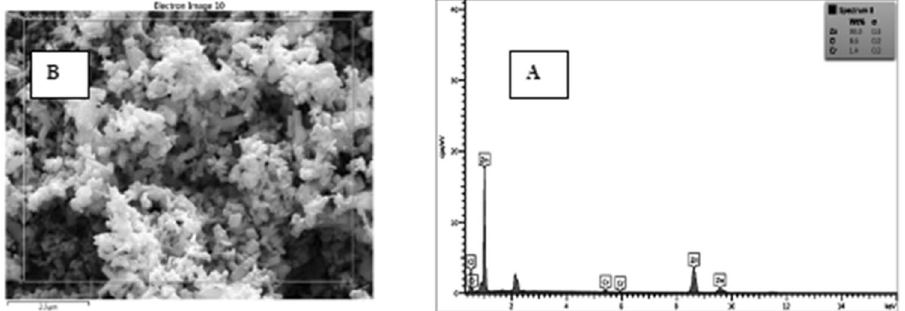
Figure 4. EDX diagram based on the powder of zinc oxide nanoparticles doped with chromium